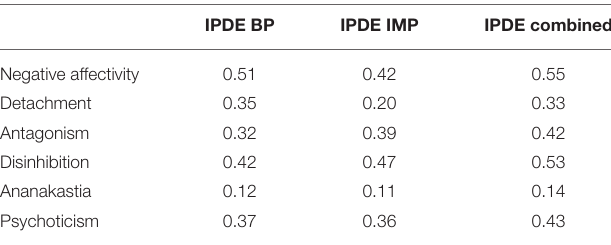
TABLE 6 | Correlations of 36-item PID5BF + M domains and IPDE-defined emotionally unstable